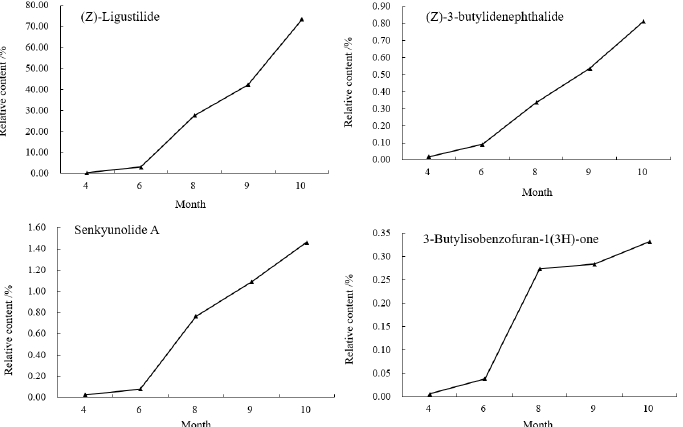
Figure 7. Changes of chemical components in the tail of A. sinensis in different periods. 3.4. Analysis of the Differences in the Accumulation of Compounds in Different Medicinal Parts of A. sinensis The number of compounds identified in different medicinal parts of A. sinensis in different periods was shown in Table 4. From April to October, the number of compounds in the head, body and tail of A. sinensis showed an increasing trend. In April, there was one less compound in the tail than in the head and body. In June, there were 11 and 7 more compounds in tail than head and body, respectively. It mainly contained olefin com- pounds such as β -chamigrene and 1,2,6,6-tetramethylcyclohexa-1,3-diene and ester com- pounds such as (Z)-9-octadecenoic acid, methyl ester and 7,10-octadecadienoic acid, etc. Since then, the species of compounds in the tail of A. sinensis were always the highest. During the harvest period, the number of species gradually reached a balance, and the number of compounds in head, body and tail were 61, 68 and 69, respectively, and there were differences in the types of components. In the harvest period, 6-epi-shyobunol only existed in the head of A. sinensis , eicosapentaenoic acid was found only in the body of A. sinensis , and 10,13- Octadecadiynoic acid and α -Elemen were only found in the tail of A. sinensis . 9-Hexadecenoic acid, 9-Octadecen-12-ynoic acid methyl ester, limonen-6-ol, pivalate, (+)-cuparene, carveol and (Z,Z)-9,12-octadecadienoic acid were not found in the head but existed in body and tail of A. sinensis . Table 4. The number of chemical compounds of A. sinensis in different parts in different periods. Medicinal Parts of A. sinensis